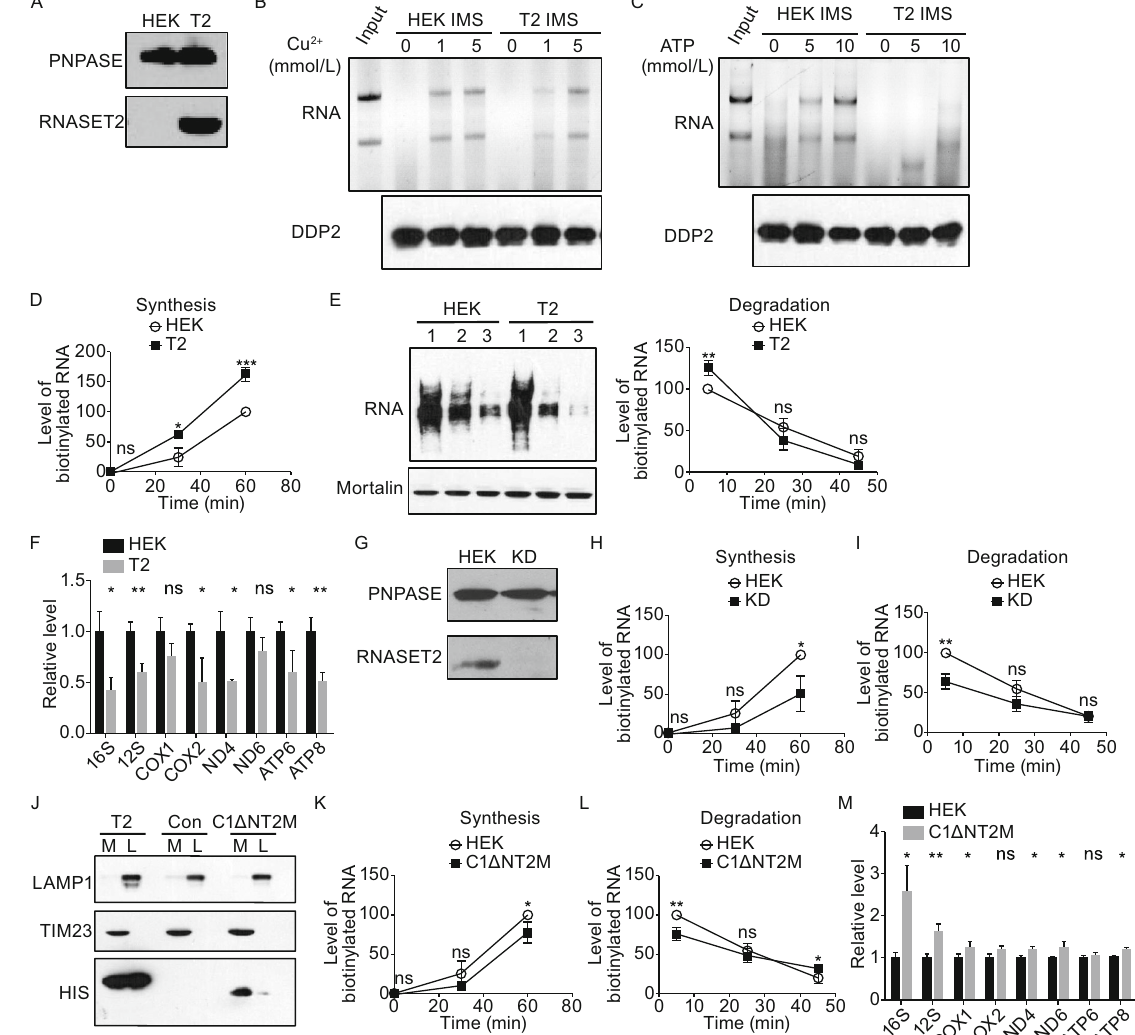
Figure 5. RNASET2 functions in mtRNA degradation. (A) Immunoblots of HEK and RNASET2-overexpressing (T2) cell lysates. PNPASE was used as a loading control. (B) IMS was isolated from HEK mitochondria or RNASET2-overexpressing (T2) mitochondria and the ribonuclease activity was tested for its sensitivity to different concentrations of Cu 2+ (1 mmol/L and 5 mmol/L). Bottom panel is an immunoblot of IMS protein DDP2 showing the relative amount of IMS used for each in vitro degradation assay. (C) IMS was isolated from HEK mitochondria or RNASET2-overexpressing (T2) mitochondria and the ribonuclease activity was tested for its sensitivity to different concentrations of ATP (5 mmol/L and 10 mmol/L). (D) In organello mtRNA synthesis in control mitochondria (HEK) and mitochondria overexpressing RNASET2 (T2). (E) In organello mtRNA degradation in control mitochondria (HEK) and mitochondria overexpressing RNASET2 (T2). (F) qRT-PCR of mRNAs in HEK and RNASET2-overexpressing cells (T2) after H 2 O 2 treatment for 2 h. (G) Immunoblots of HEK or RNASET2-knockdown (KD) cell lysates. PNPASE was used as a loading control. (H) In organello mtRNA synthesis in control mitochondria (HEK) and RNASET2-knockdown mitochondria (KD). (I) In organello mtRNA degradation in control mitochondria (HEK) and RNASET2-knockdown mitochondria (KD). (J) Immunoblots of mitochondria (M) and lysosomes (L) isolated from RNASET2-overexpressing cells (T2), control HEK cells (Con), and cells expressing C1- Δ N-RNASET2 (C65R, C118R) mutant (C1 Δ NT2M). LAMP1 was used as a lysosomal marker, and TIM23 as a mitochondrial marker. (K) In organello mtRNA synthesis in control mitochondria (HEK) and mitochondria expressing C1- Δ N-RNASET2 (C65R, C118R) mutant (C1 Δ NT2M). (L) In organello mtRNA degradation in control mitochondria (HEK) and mitochondria expressing C1- Δ N- RNASET2 (C65R, C118R) mutant (C1 Δ NT2M). (M) qRT-PCR of mRNAs in HEK and C1- Δ N-RNASET2 (C65R, C118R) mutant expressing cells (C1 Δ NT2M) after H 2 O 2 treatment for 2 h. Statistical comparisons are performed using unpaired t -tests ( n = 3 if not speci fi ed); * P < 0.05, ** P < 0.01, *** P < 0.001, **** P < 0.0001. Data are presented as mean ± standard error of the mean